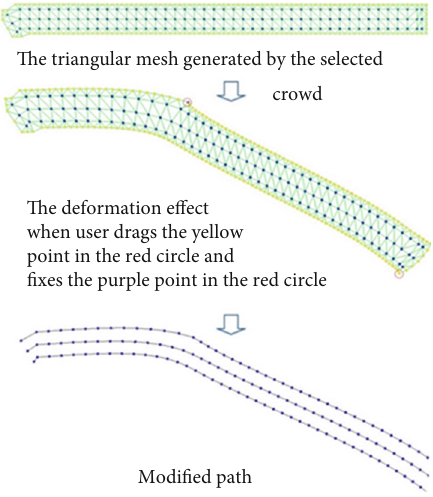
Figure 5: Dragging e ff ect with a fi xed